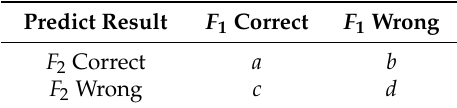
Table 3. Contingency table with two classification